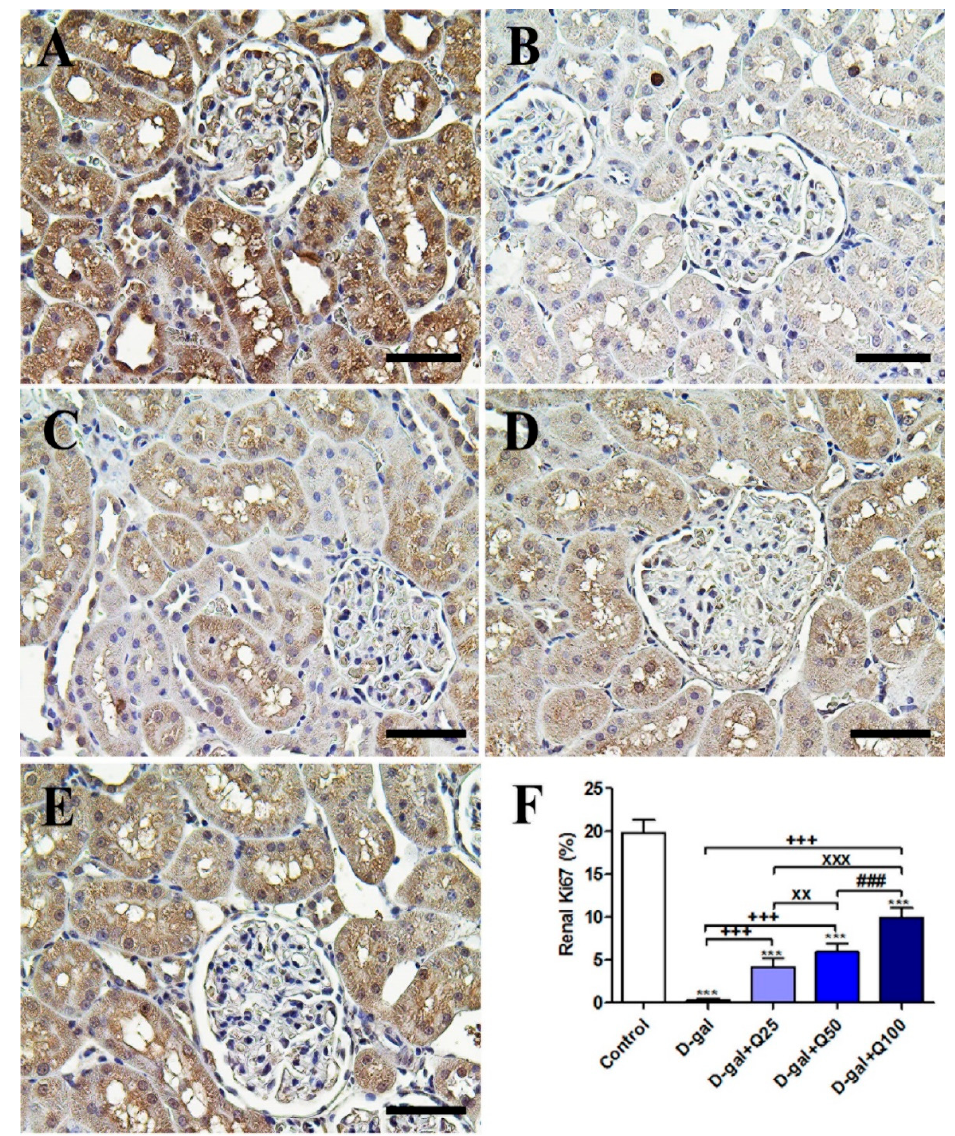
Figure 11. Immunohistochemical staining of rats’ kidney with Ki67. ( A ) Negative control group. ( B ) D-gal group. ( C ) D-gal + Q25 group. ( D ) D-gal + Q50 group. ( E ) D-gal + Q100 group. ( F ) Quantification of Ki67 in the renal tissues in different groups. Scale bar = 50 µm . Data were analyzed with one-way ANOVA followed by Tukey’s multiple comparison test. *** p < 0.001 vs. control. +++ p < 0.001 vs. D-gal. xx p < 0.01 and xxx p < 0.001 vs. D-gal + Q25. ### p < 0.001 vs. D-gal + Q50. Error bars represent mean ±